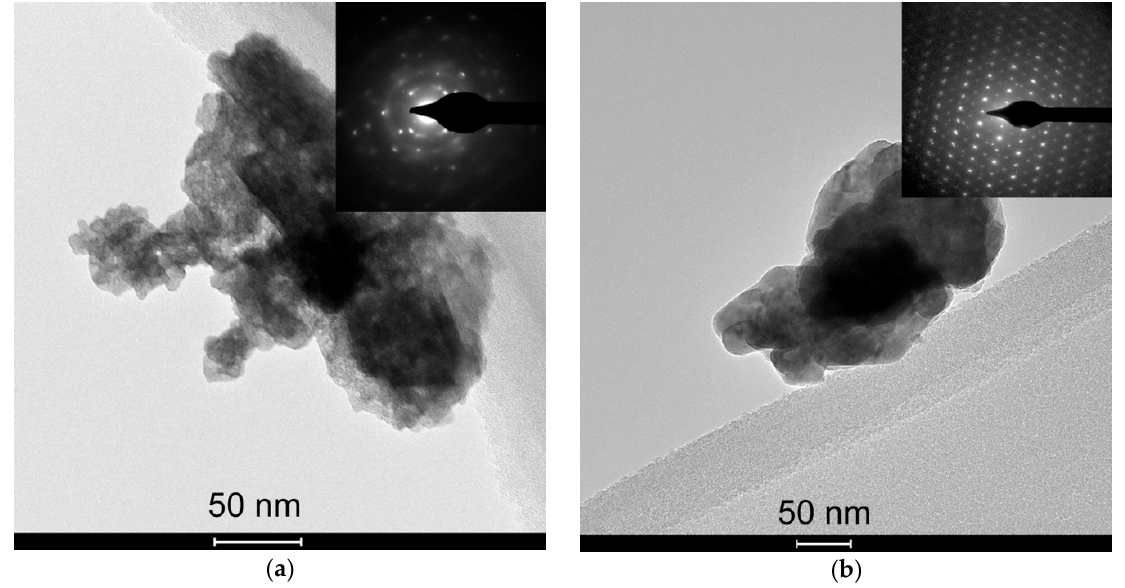
Figure 2. Mean grain size and BET area of WO 3 in relation to annealing temperature.